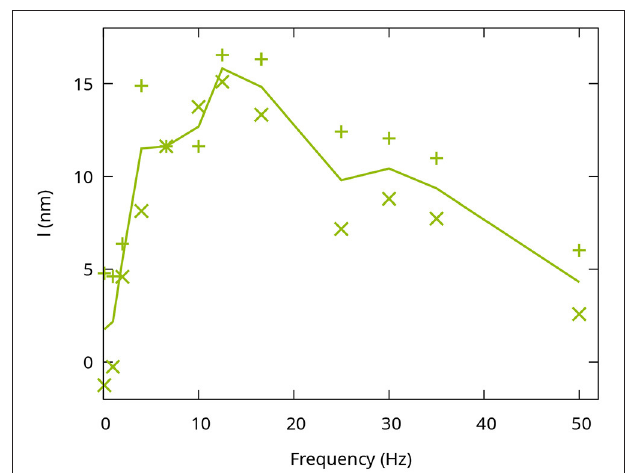
FIGURE 3 | Frequency dependence of the functional phase change in the IPL. The optical path length changes I reached after 8 s were evaluated. Each point corresponds to an individual measurement. The line connects the average of the two measurements at each